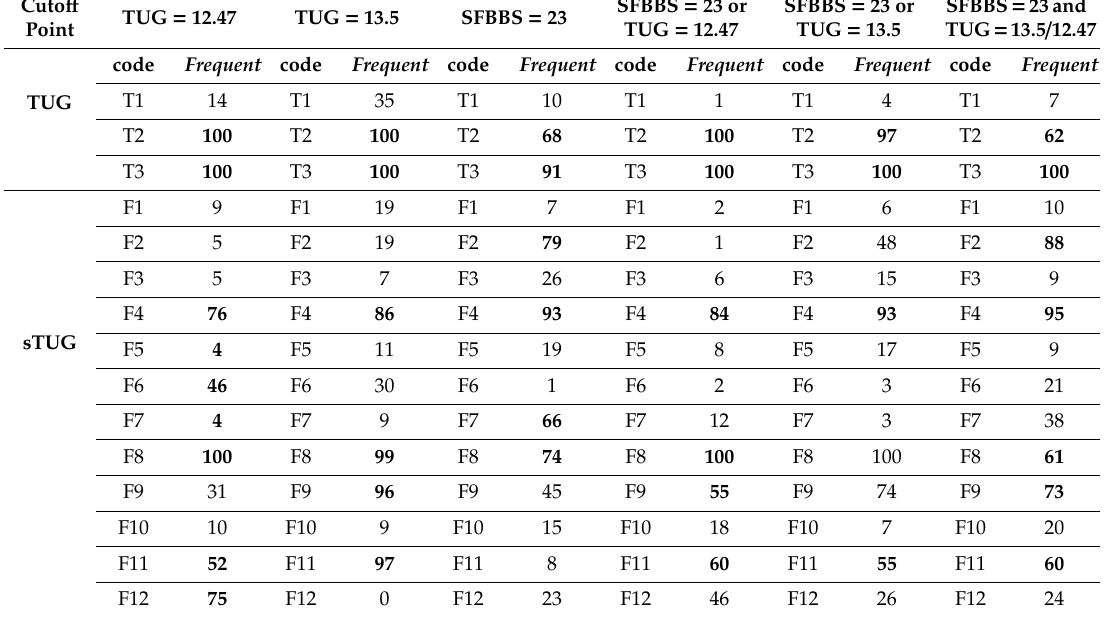
The results for the stepwise regression of the 100-iteration, random-shu ffl e-split cross-validation